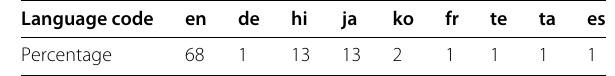
language code is identified using ISO-639 [19]